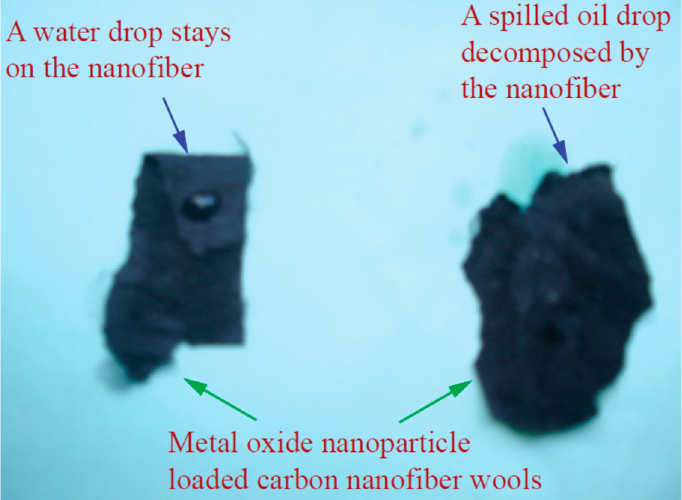
Figure 7. Photographs showing the hydrophobic and oleophilic behaviors of the composite carbon fiber.